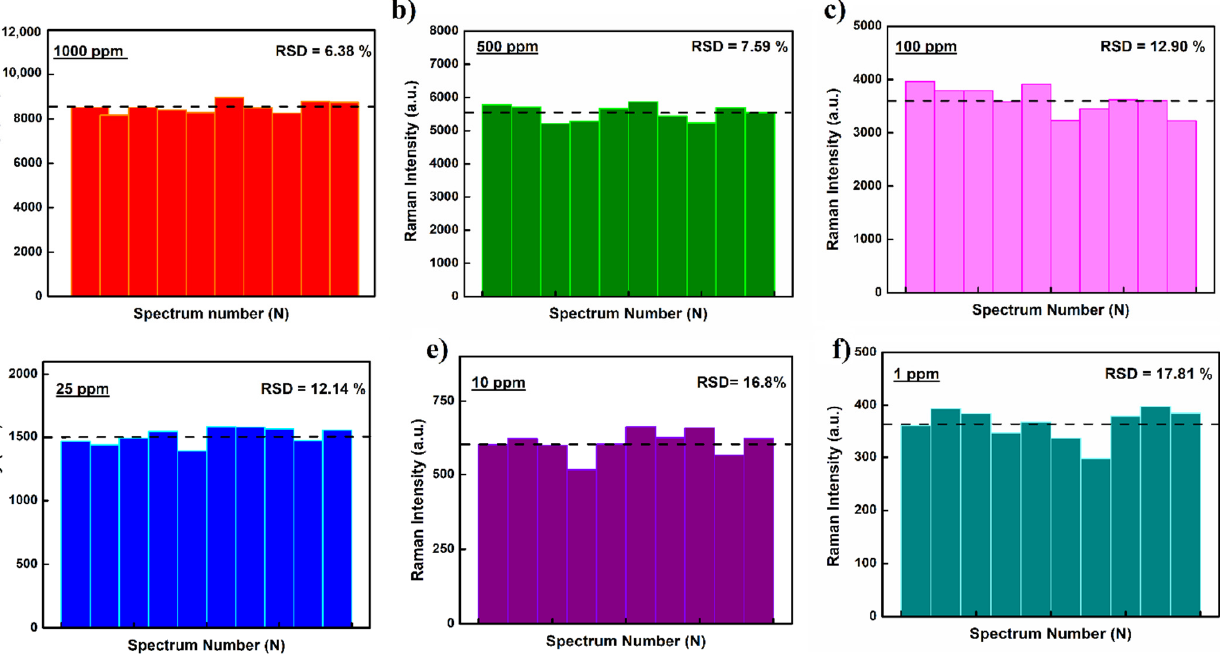
Figure 3. ( a − f ) SERS intensity variability for tested DA concentrations collected at random locii on the fabricated AgNps-DE substrates. RSD = relative standard deviation of the SERS signal. The dotted black line represents the average intensity value for peak reflection at 1609 cm − 1 for respective tested concentration.